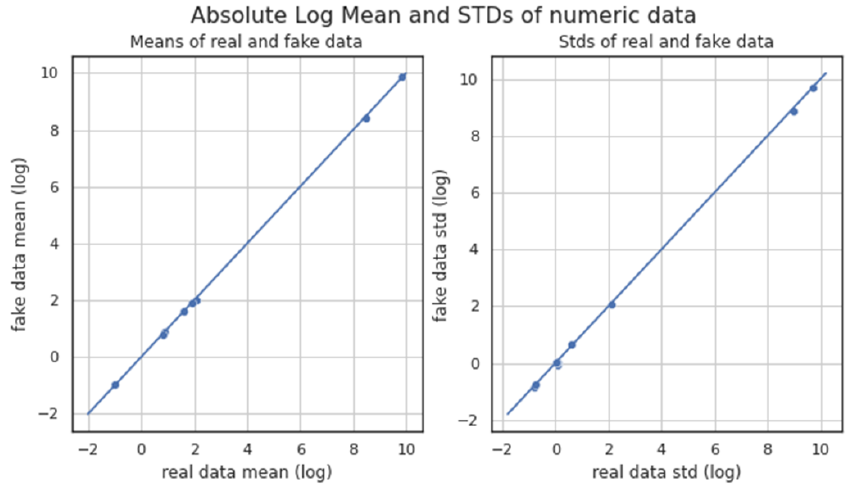
Figure 7. Absolute, log, mean and STD of original (real) and generated (fake) data.